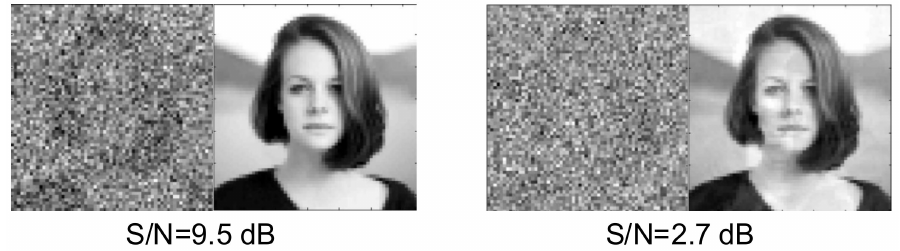
Figure 10. Reconstruction of distorted images (Items 10 and 14 in Table